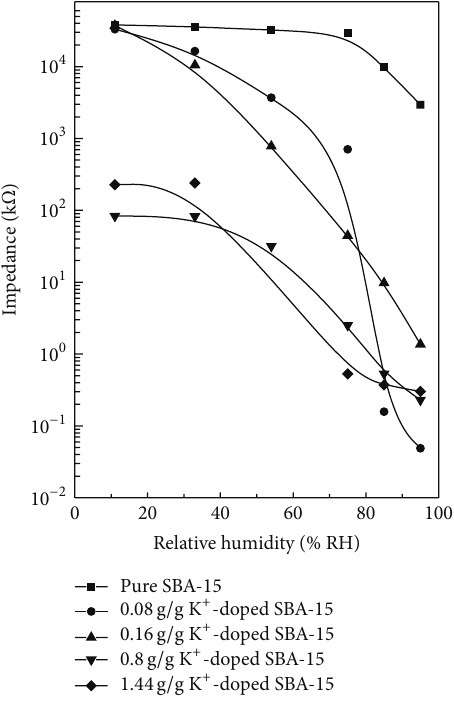
Figure 6: The dependence of resistance on RH for pure SBA-15 and K + -doped samples.